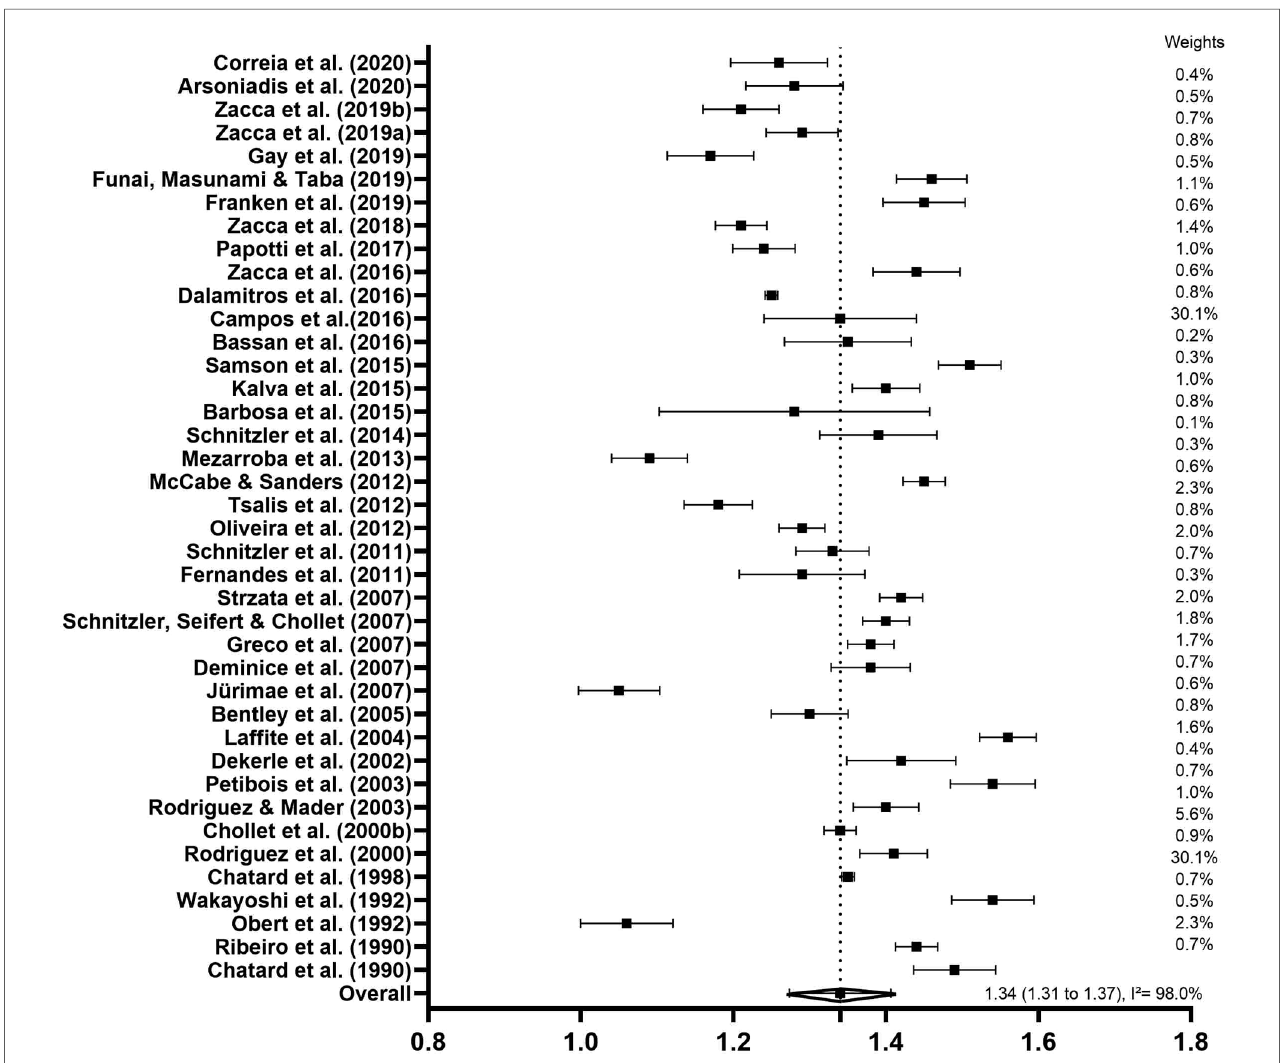
FIGURE 2 Forest plots derived from continuous random-effects models depicting the kinematics parameters represented by clean swim speed (m·s − 1 ) in 400-m front crawl